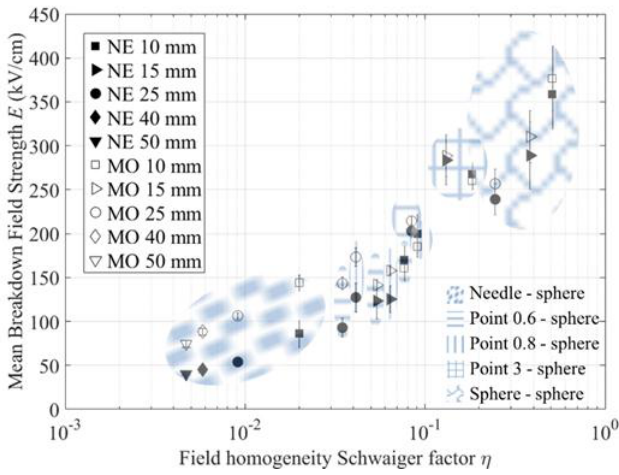
Figure 3. Mean breakdown field strength over the range of investigated inhomogeneity at negative polarity for mineral oil and natural ester liquid.